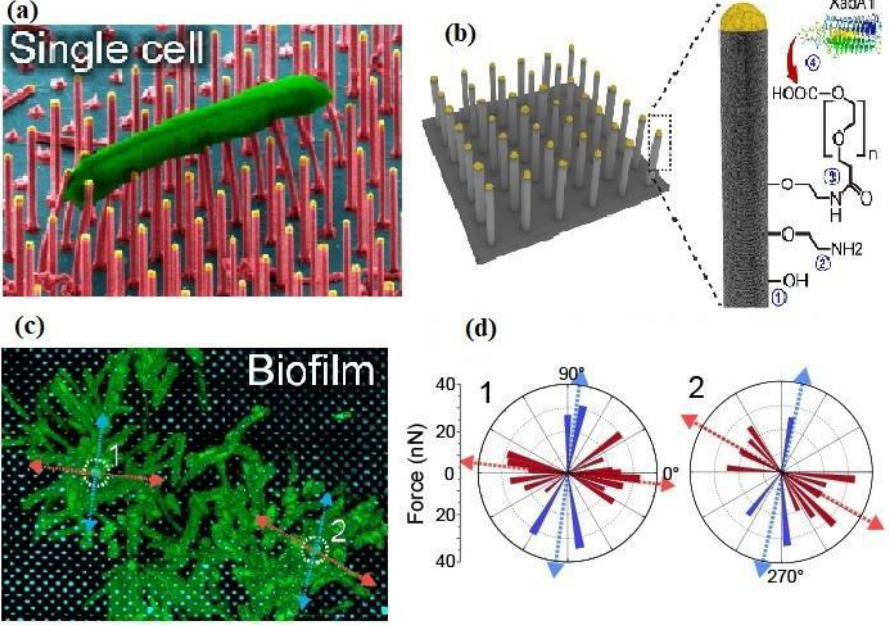
Figure 11. Adhesion force for anchoring a single-cell to a biofilm. ( a ) Image showing the deformation of nanowires in direct contact with the attached cell body (colorized in green). ( b ) Schematic representation of the functionalization protocol for the indium phosphide (InP) nanowire array using polyethylene glycol (PEG) cross-linker and XadA1 adhesin. ( c ) Confocal laser scanning fluorescence microscopy (CLSM) image of the small biofilm, with the marked position of the two nanowires and the average directions shown in c. ( d ) The magnitude and direction of the forces calculated for the two nanowires with arrows indicating the predominant, average direction of movement; the noise was excluded by only considering forces with values larger than control +10%. (Reproduced with permission from [134] under Copyright (2016) American Chemical Society).